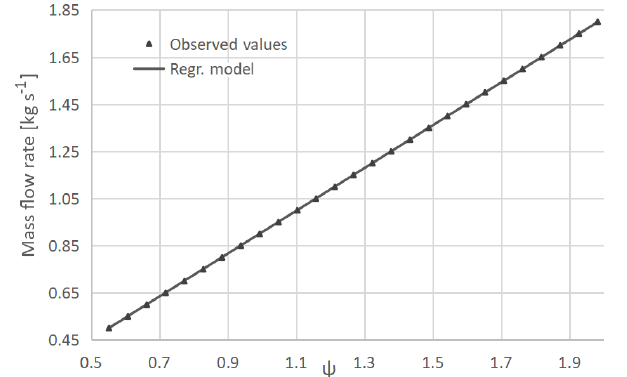
Figure 24. C d coefficient against inlet mass flow rate.